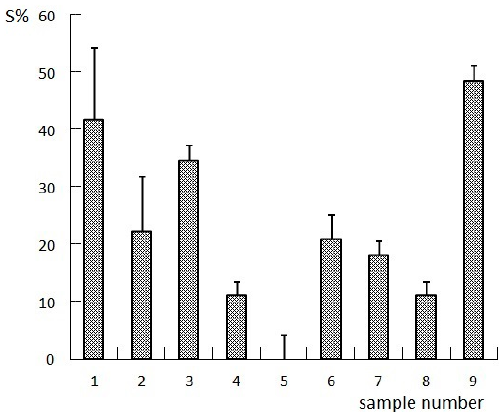
Figure 2. Results of S% (the survival extension rate) in tumor-bearing nude mice.